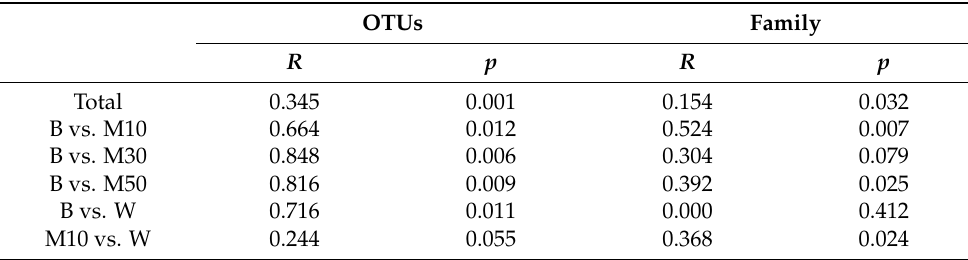
Table 1. Permutational multivariate analysis of variance of the microbial diversity among different phases.